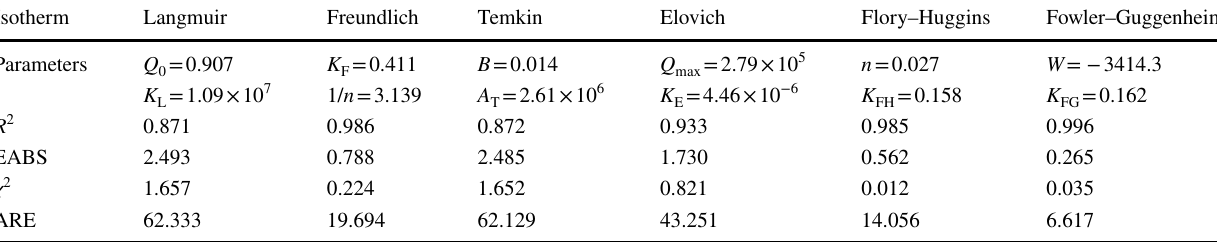
q e(exp) are experimental values, is the number of data points, and p is the number of parameters in the isotherm